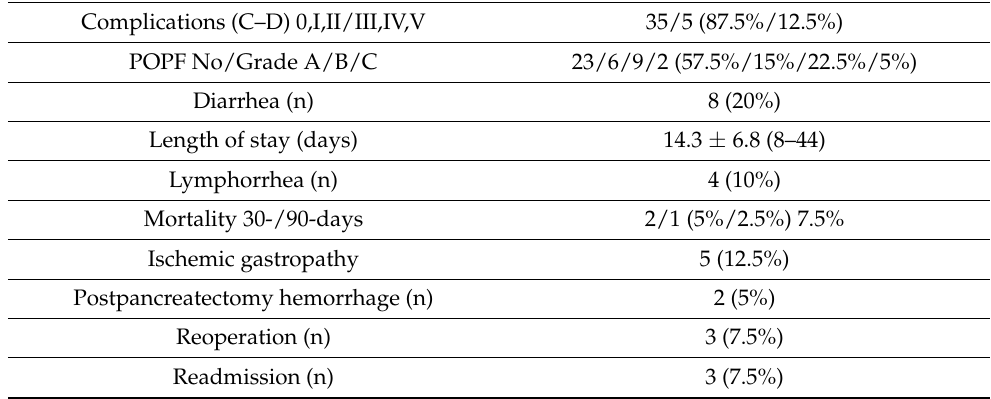
Table 2. Morbidity after DP-CAR